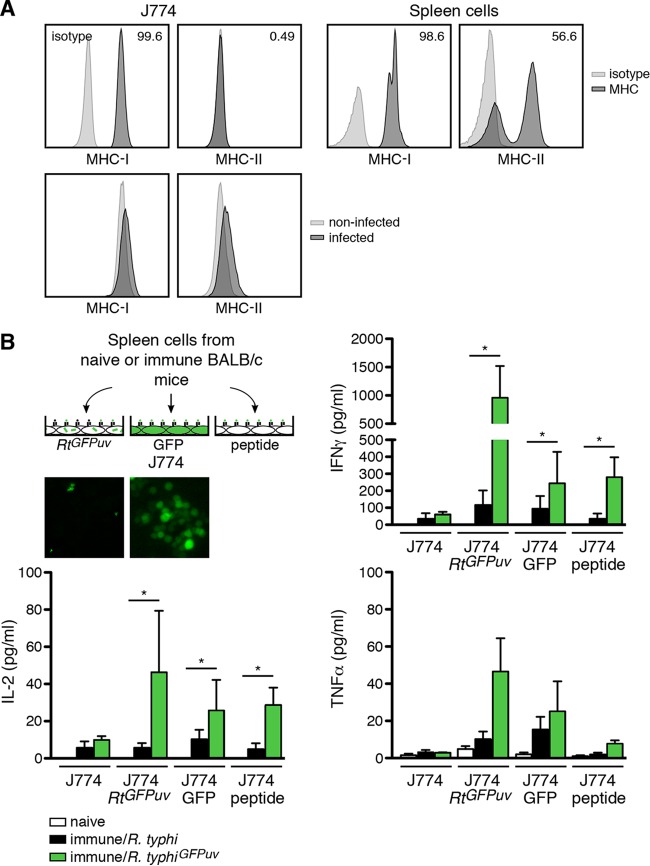
GFP-specific CD8+ T cells from R. typhiGFPuv-infected mice produce IFN-γ, IL-2, and TNF-α. (A) J774 cells were used as antigen-presenting cells in GFP-specific restimulation assays. (Top left) J774 cells were stained for extracellular MHC-I and MHC-II. (Top right) As a control for the antibody staining, spleen cells from BALB/c mice were used. (Bottom) In addition, J774 cells were infected with R. typhiGFPuv and analyzed for MHC-I and MHC-II expression. J774 cells do not express MHC-II and minimally upregulate MHC-II upon R. typhi infection. (B) Different approaches were used for the restimulation of spleen cells from R. typhi-infected BALB/c mice. J774 cells were either infected with R. typhiGFPuv or transduced to express cytosolic GFP 2 days prior to the assay or pulsed with GFP200–208 peptide 2 h before addition of spleen cells. The insets show examples of fluorescence images from R. typhiGFPuv-infected and GFP-expressing J774 cells, as they were used for the assay. BALB/c mice (n = 3) were infected s.c. with 1 × 106 SFU wild-type R. typhi or R. typhiGFPuv. Control animals received PBS (naive). Spleen cells were isolated on day 7 postinfection; 2 × 105 cells were cocultured with 4 × 105 J774 cells, treated as described above or left untreated (x axis), in 96-well round-bottom plates in RPMI 1640 cell culture medium with 5% FCS. Cytokines were quantified in the supernatants using the Legendplex assay 48 h after the addition of spleen cells. Shown are means and SEM of the concentrations of IFN-γ, TNF-α, and IL-2 (y axis). Other cytokines were not detectable. Statistical analysis was performed by one-way ANOVA (Kruskall-Wallis test, followed by Dunn's posttest). The asterisks indicate statistically significant differences (*, P < 0.05).